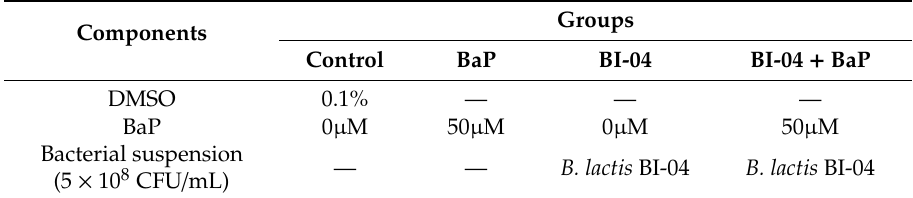
Table 1. Treatments of colon epithelial